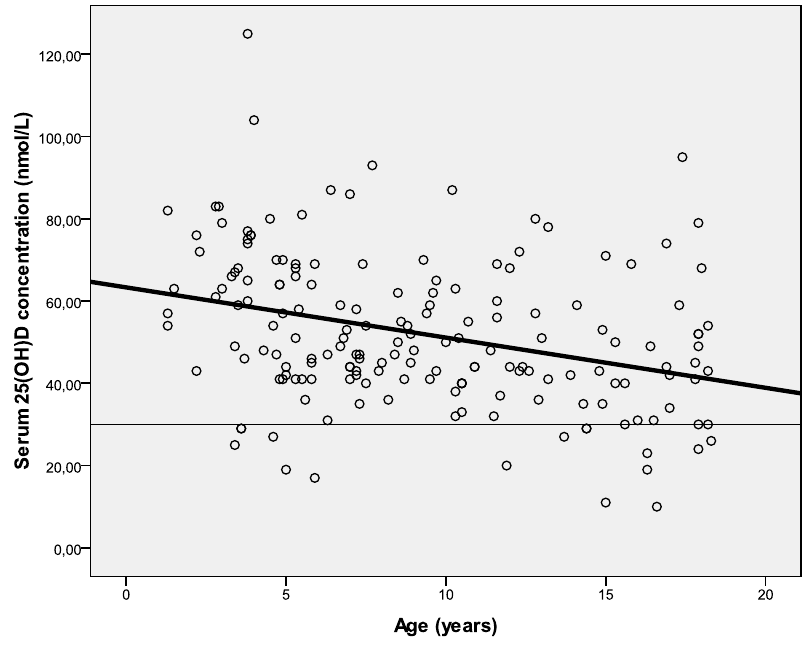
Figure 1. Mean serum 25(OH)D 3 concentration per age.